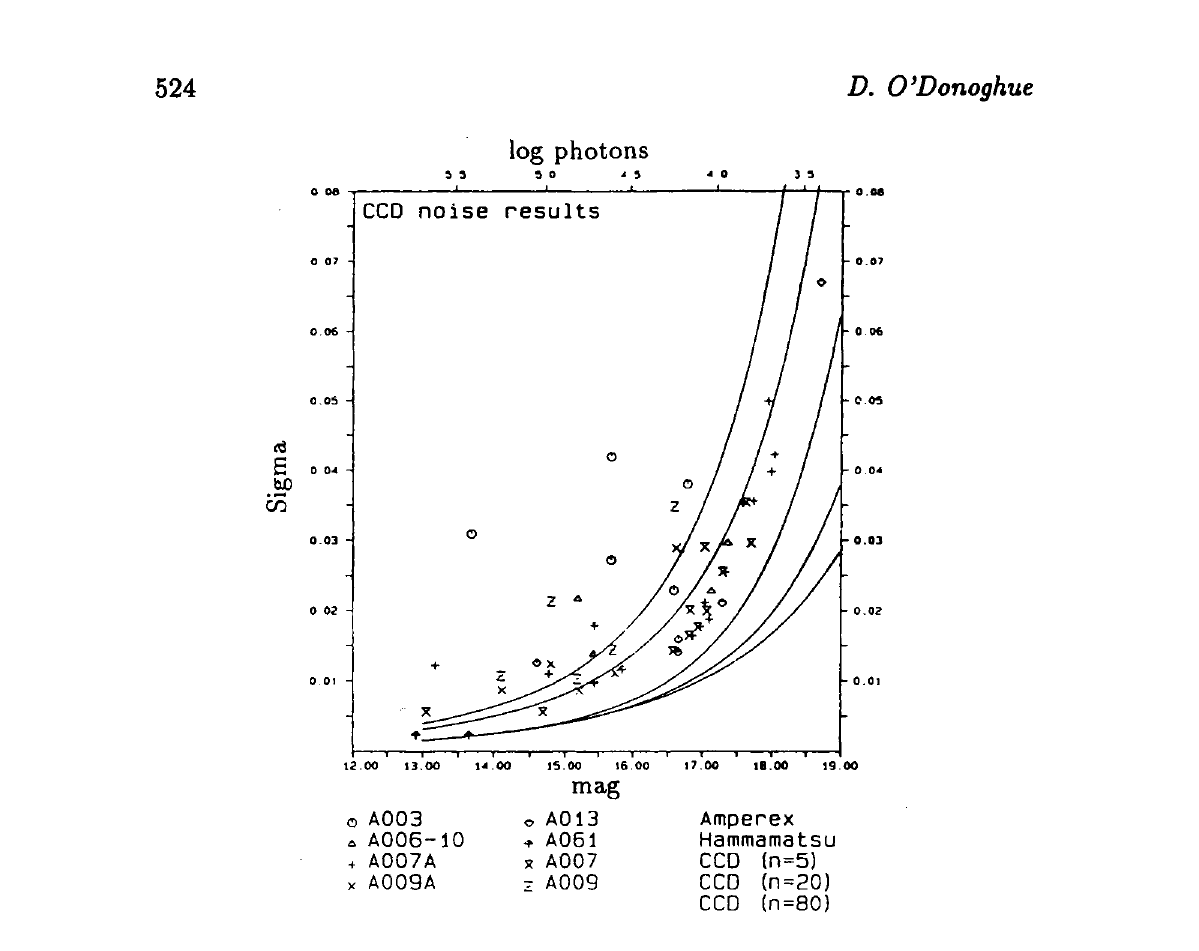
Fig. 1. Noise results for the high speed CCD photometer. The or- dinate is the standard deviation of the detrended light curves. The top abscissa scale indicates the number of photons detected in 10 s, the bottom abscissa scale indicates the "white light" magnitude of the star (roughly a broad V). Light curves of stars from the same CCD run are plotted with the same symbol and the corresponding run is indicated in the key below. The leftmost two solid curves are theoretical noise curves for photomulti- pliers and the rightmost three are theoretical noise curves for the CCD. See text for